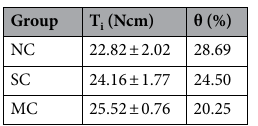
Table 3. RTVs (T i ) and torque loss rates (θ).